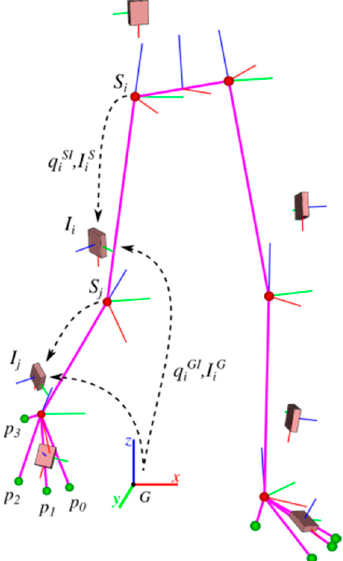
Figure A1. Biomechanical model of the lower body with segments (magenta lines), joint centers (red spheres), four ground contact points on each foot (green spheres), IMU placement, and involved coordinate frames. A technical coordinate system is associated to each IMU ( I ). The segment coordinate systems ( S ) are drawn at the proximal ends of the segments. The six DoF transformations, each in terms of an orientation (quaternion) q SI and a translation I S , between the IMU coordinate frames and the associated segment coordinate frames are called IMU-to-segment calibrations. The symbol G denotes the global coordinate system. The figure has been taken from [14].